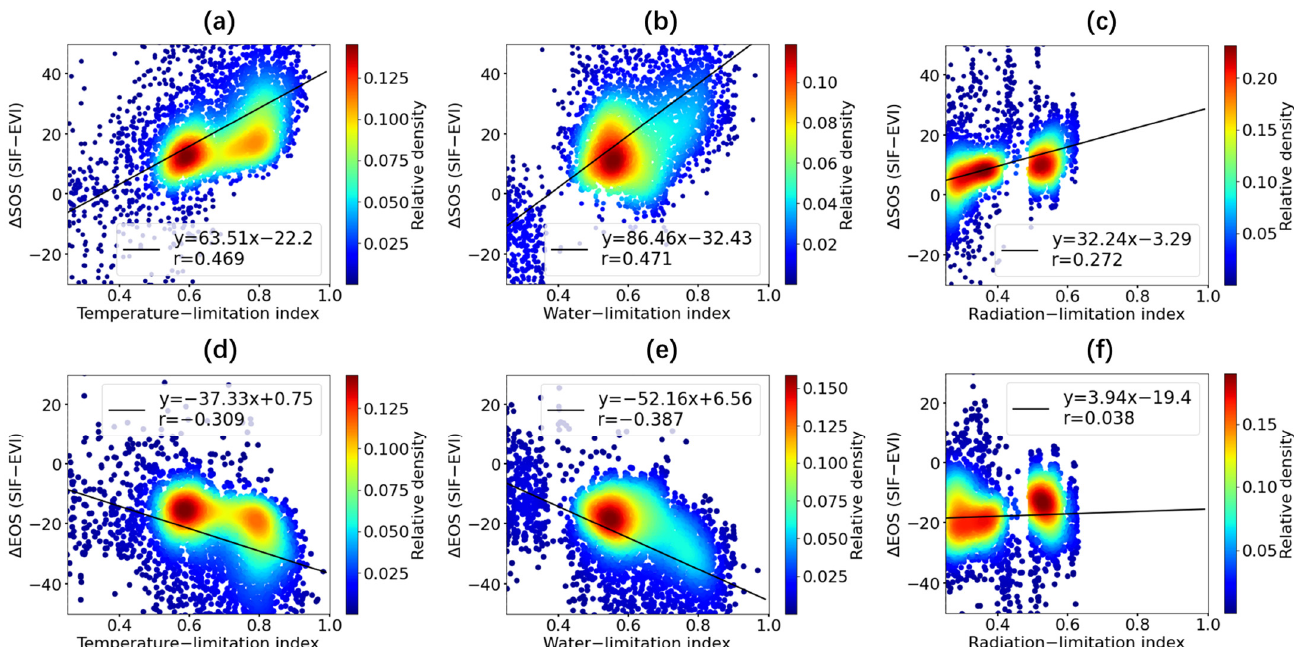
Figure 4. Scatterplot of differences of SOS ( first row ) and EOS ( second row ) derived from SIF and EVI versus climatic limitation index at temperature-dominant area ( a , d ), water-dominant area ( b , e ) and radiation-dominant area ( c , f ). The black line shows the linear regression between phenology from SIF or EVI and climatic limitation indices; r is the correlation coefficient of the linear regression.